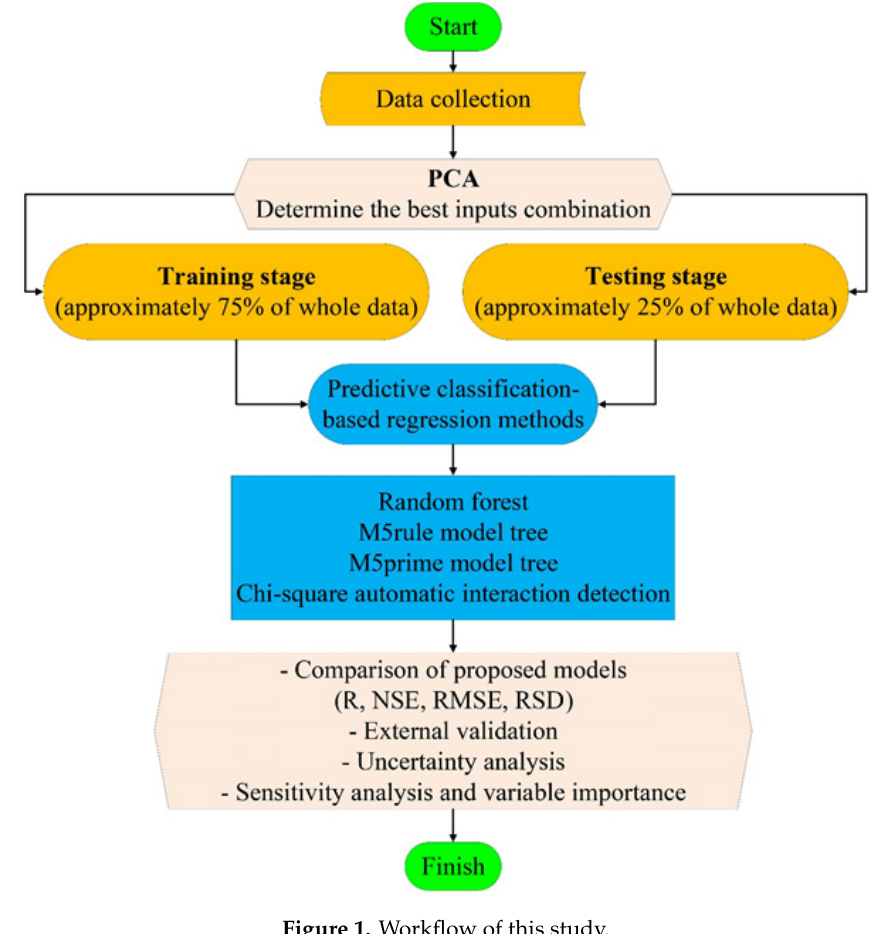
Figure 1. Workflow of this study.